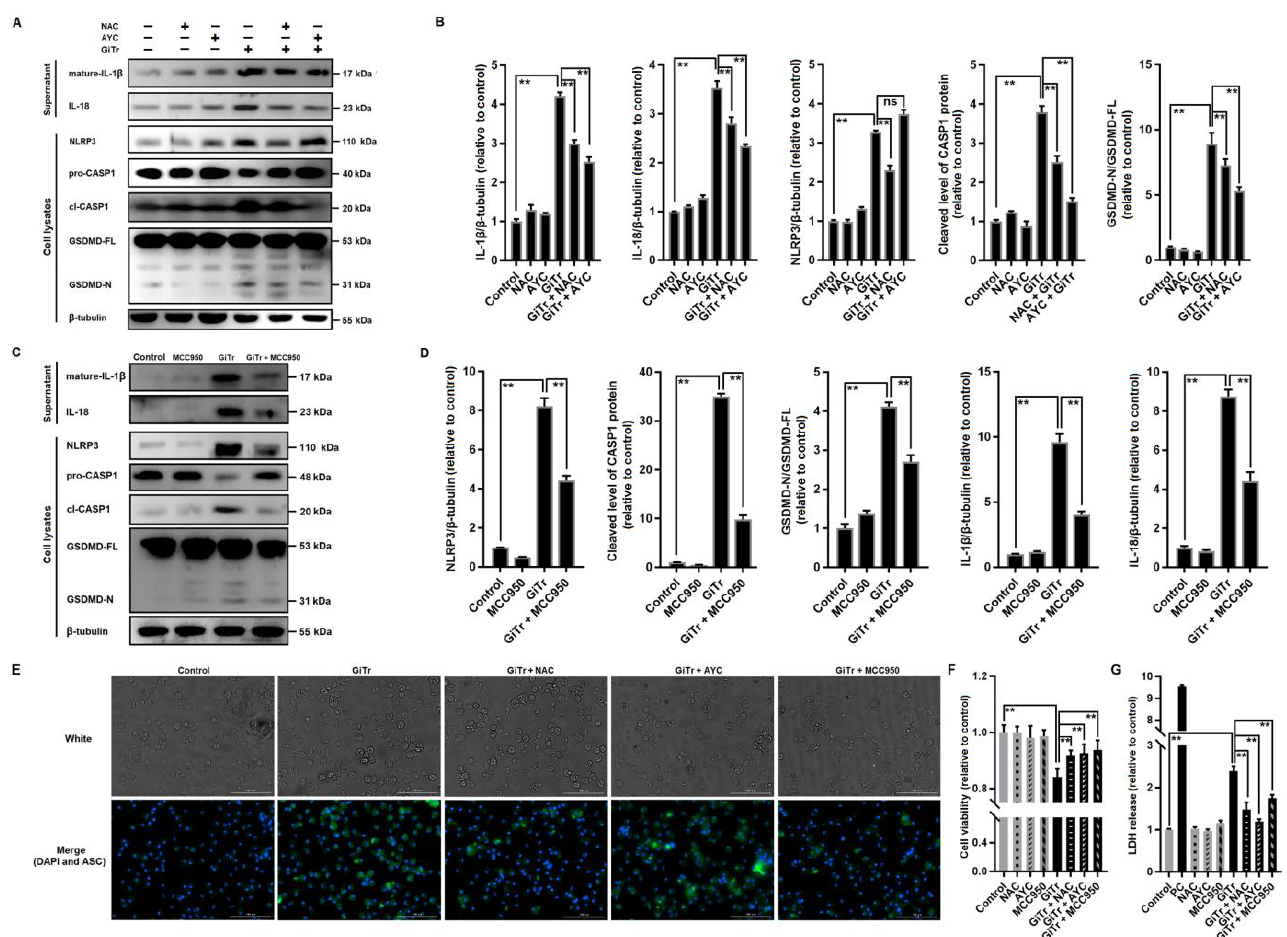
Figure 3. Giardia -induced ROS/NLRP3/CASP1/GSDMD-mediated macrophage pyroptosis. PMs were pretreated with 10 µ M NAC, 40 µ M AYC, or 50 µ M MCC950 for 2 h, and stimulated with trophozoites at a ratio of 10 parasites/cell for 12 h. ( A , B ) The effects of NAC or AYC pretreatment on Giardia -induced upregulation of NLRP3, cleavage of CASP1 and GSDMD, and secretion of IL-1 β and IL-18 were analyzed by Western blotting. ( C , D ) The effects of MCC950 pretreatment on Giardia - induced cleavage of CASP1 and GSDMD and secretion of IL-1 β and IL-18 were analyzed by Western blotting. ( E ) After pretreatment with NAC, AYC, or MCC950, ASC expression in Giardia -treated PMs was detected by immunofluorescence assay (scale bar = 100 µ m). ( F , G ) NAC, AYC, or MCC950 pretreatment affected the Giardia -induced decrease in cell viability and increase in LDH release. All experiments were repeated at least three times. ( A , C , E ) Representative pictures are shown. ( B , D , F , G ) Values are expressed as the mean ± SD (** p < 0.01 as compared to nontreated controls or as indicated). GiTr: reads Giardia trophozoites, and ns: no significant